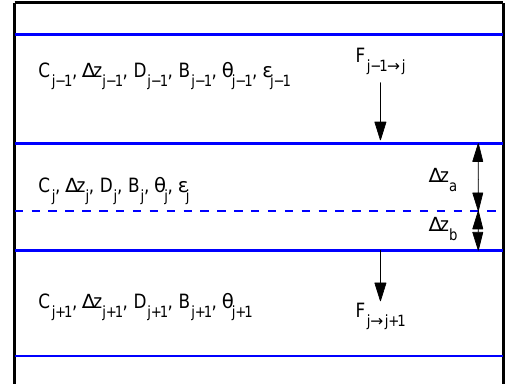
Fig. 2. Numerical model configuration when the water table (dashed line) is inside a grid layer. Subscript “a” indicates variables that are defined above the water table (or wetting front), and subscript “b” indicates variables that are defined below the water table (or wetting front). Three grid layers are considered: j − 1, j , and j + 1. Relevant symbols are defined in the